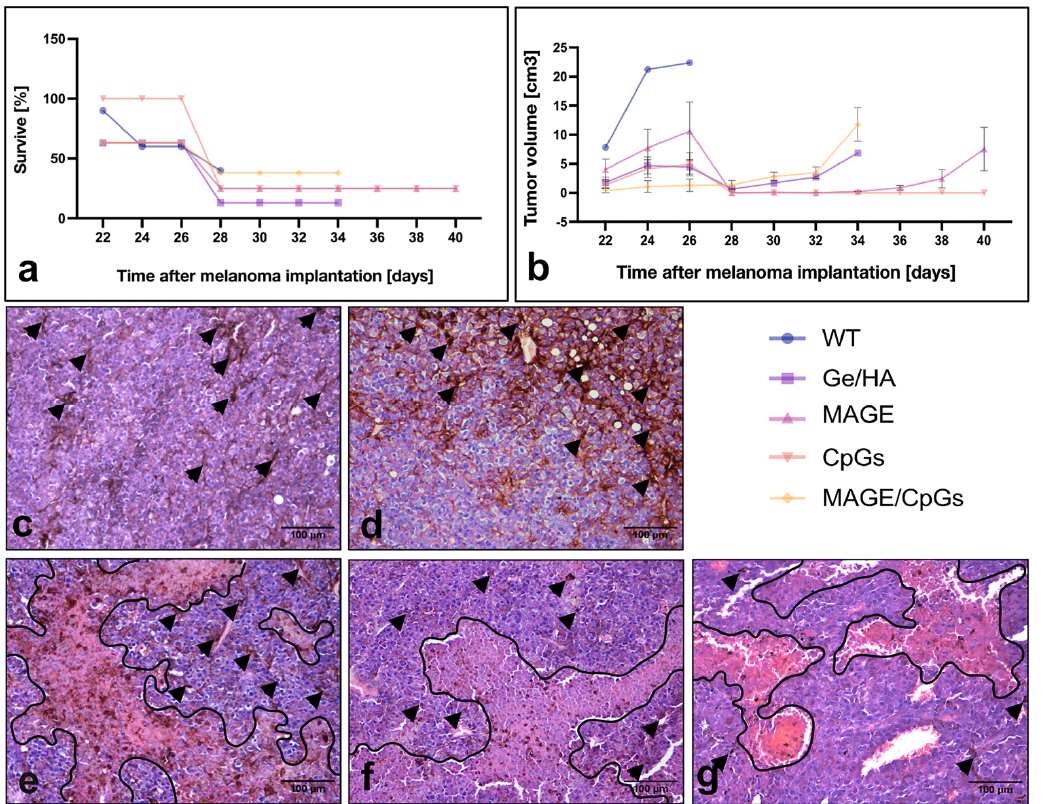
Figure 6. Histopathological study of the tumor parenchyma, survival, and tumor growth rate of the mice with melanoma treated with Ge/HA coupled to CpG or MAGE-A5: ( a ) survival and ( b ) tumor growth rate of the mice with melanoma treated with Ge/HA scaffolds coupled to MAGE-A5 and/or CpG; ( c ) without treatment (WT); ( d ) Ge/HA; ( e ) CpG; ( f ) MAGE-A5; ( g ) MAGE-A5/CpG. WT mice possessed a tumor stroma made up of abundant viable and active cells with basophilic staining and a few acidophilic regions typical of areas with abundant nonviable cells. The CpG and MAGE-A5 groups had tumor stroma with some basophilic viable cell areas and abundant acidophilic regions typical of cell death areas. Scaffolds coupled to CpG and MAGE-A5 contained both acidophilic and basophilic regions, in addition to cells with melanin (arrowheads). The groups treated with the scaf- folds coupled to CpG or MAGE-A5 showed the lowest tumor growth rate and the highest percent- age of survival. The areas of necrosis in histological sections were outlined (black line) to better visualization. The tumor growth rate was also analyzed. The group treated with Ge/HA/CpG showed the lowest tumor growth rate of all groups; even among the treated mice, only some developed tumor lesions. As a result, from day 28 post-inoculation, a tumor growth rate of zero was maintained. The group treated with Ge/HA/MAGE-A5 showed a similar